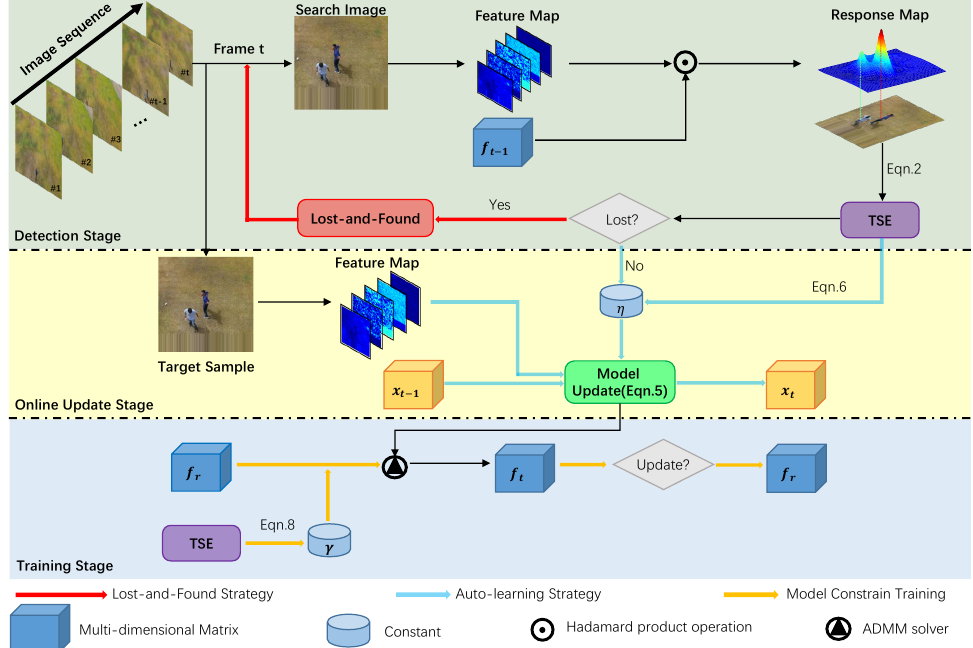
Figure 2. The overall framework of ALCF comprises three stages, i.e., detection, online updating, and